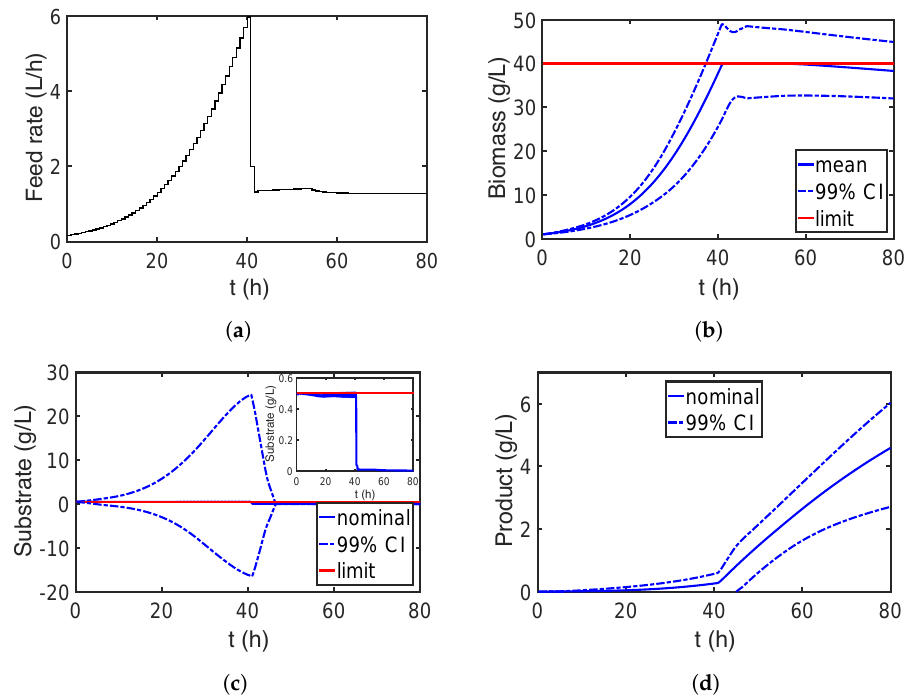
Figure 12. ( a ) Feeding profile; evolution of the ( b ) biomass; ( c ) substrate and ( d ) product obtained from the nominal design, where the parameter uncertainties are neglected. In turn, the blue dotted lines illustrate the effect of the parameter